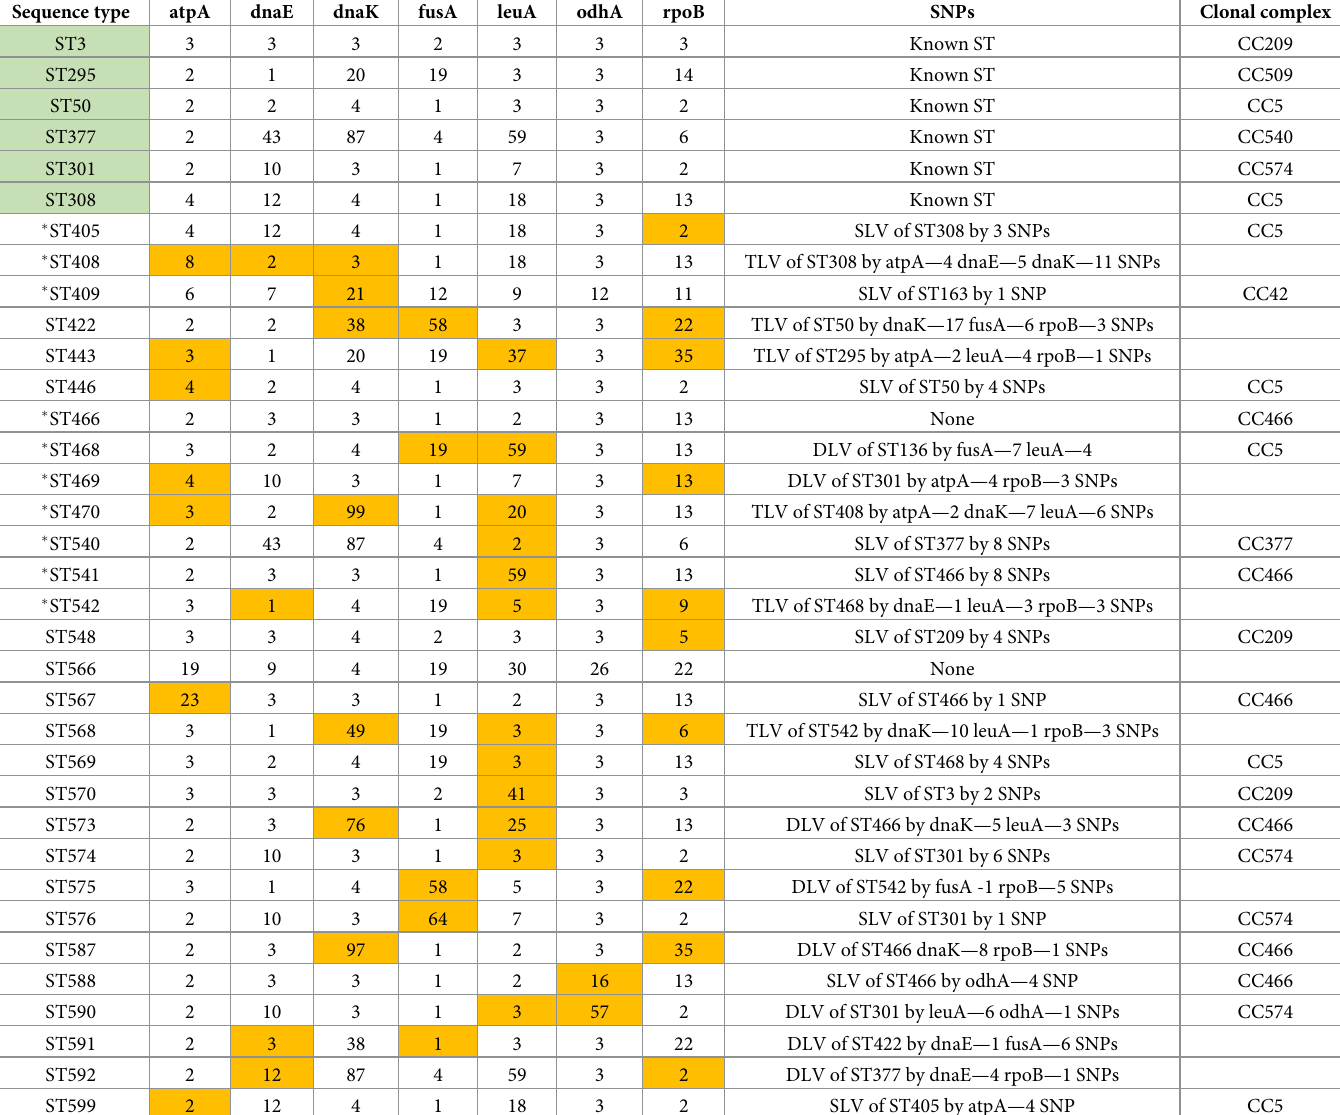
Table 1. SNP analysis of sequence types identified among the study isolates. Sequence